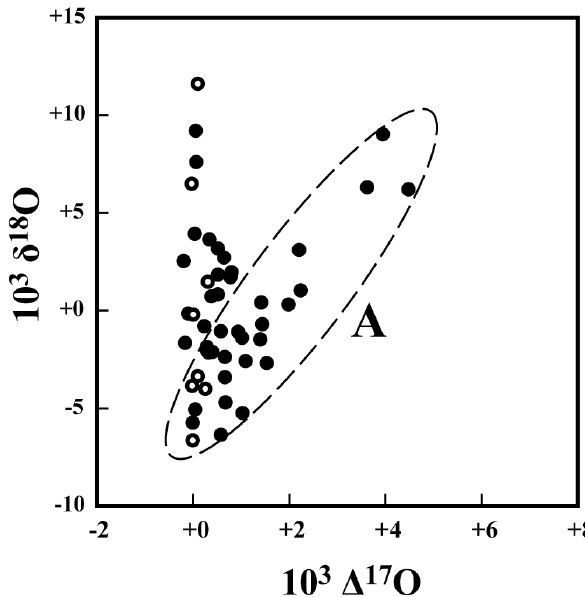
Fig. 3. Relationship between 1 17 O and δ 18 O in NO − water samples. The open circles denote those showing δ 15 N values of more than +